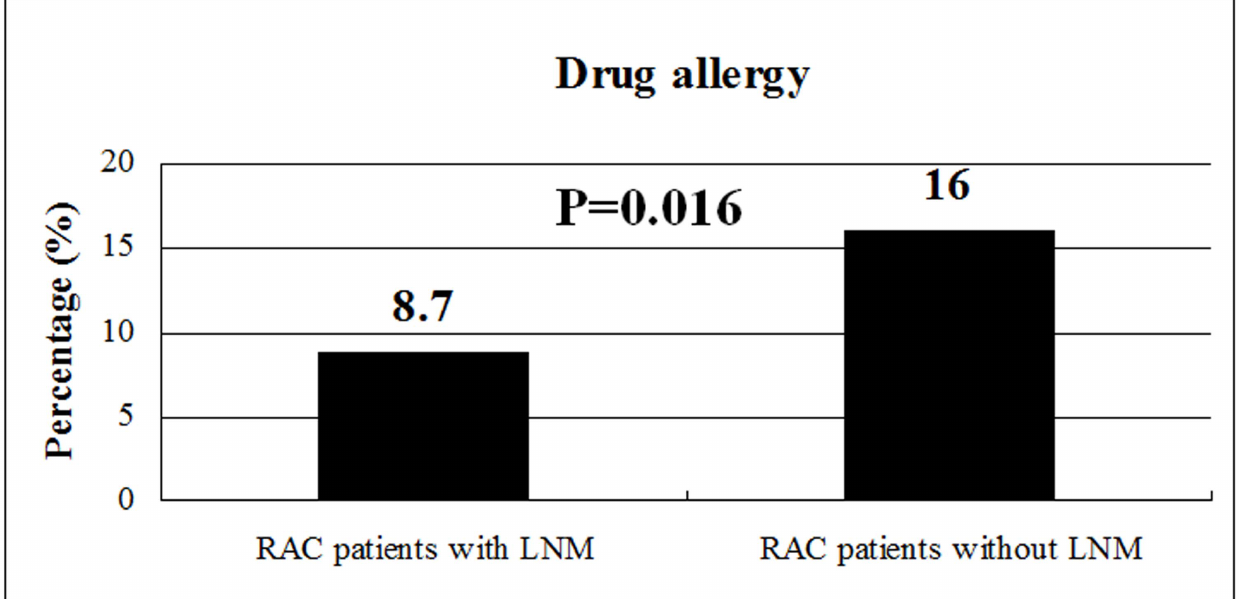
Figure 1. Univariate analysis showed that the percentage of drug allergy was lower in rectal adenocarcinoma (RAC) patients with pathological lymph node metastasis (pLNM) compared with those patients without pLNM (8.7% vs. 16.0%, P=0.016).